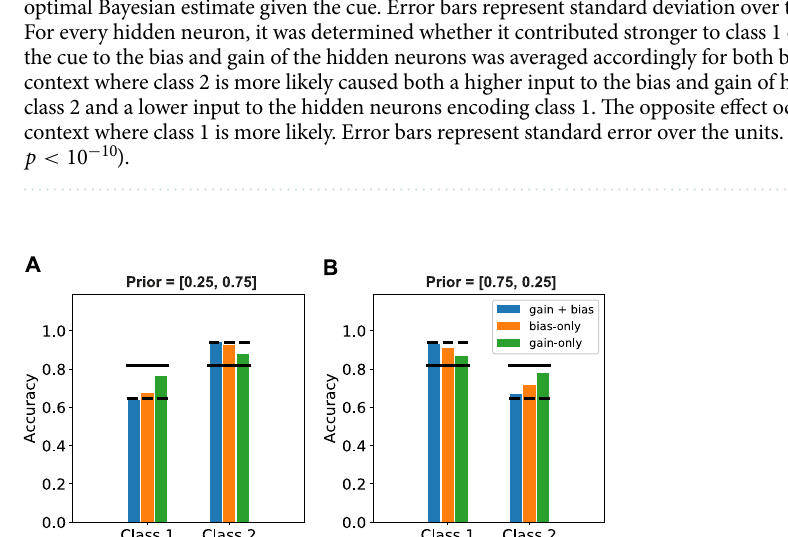
model with Poisson input neurons and ReLU hidden units as for the discrete case was used. Instead of a softmax output layer, we used a linear readout for the continuous case. The mean squared error loss was used to optimize the parameters of the network through backpropagation. First we compare the performance of the model again with the Bayesian optimal posterior, to test whether it shows Bayesian optimal behaviour. The neural population learned to estimate the stimulus in a Bayesian way, correctly incorporating the prior knowledge about the relative frequency with which a stimulus was presented (Fig. 8). A uniform prior or maximum likelihood estimate did not match the network output for priors differ- entiating strongly from uniform (Fig. 8, right panel).